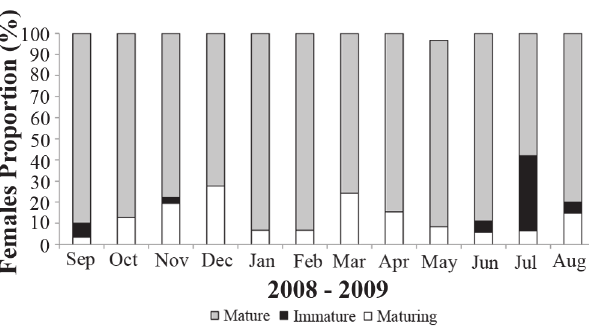
Fig. 7. Proportion of Anableps anableps females by stage of gonadal maturity in the mouth of the Maracanã River, Pará